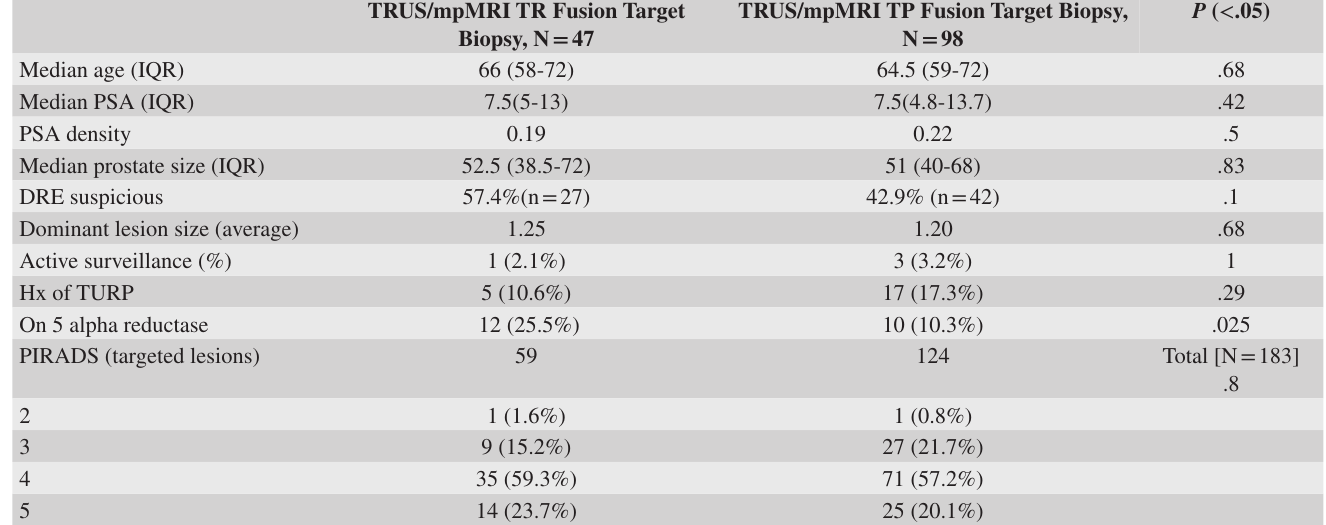
Table 1. Patient Demographics, Distribution of mpMRI Findings, and Summary of MRI/US-Fusion Biopsy